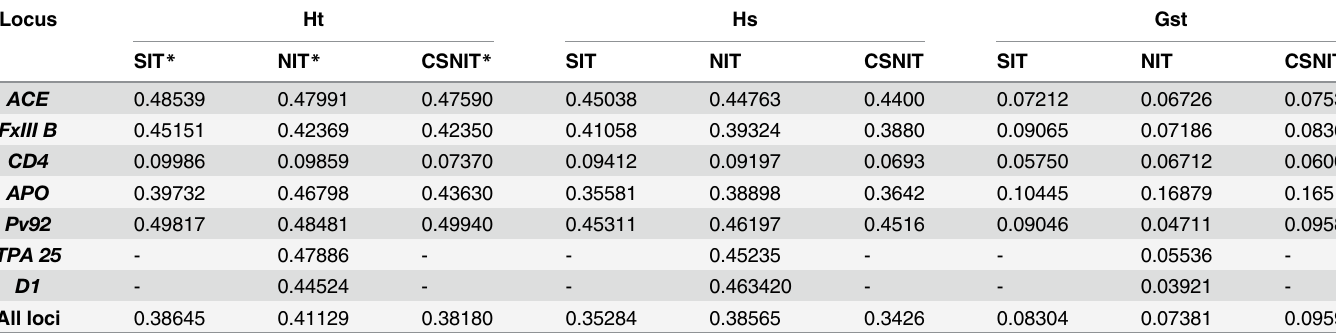
Table 2. Gene diversity analysis of individual loci, and all loci considered jointly in tribal populations.